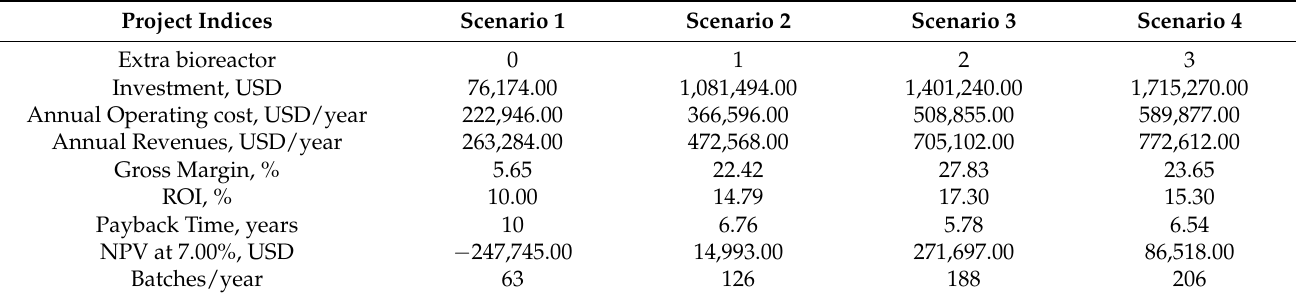
Table 5. Economic evaluation under different scenarios.